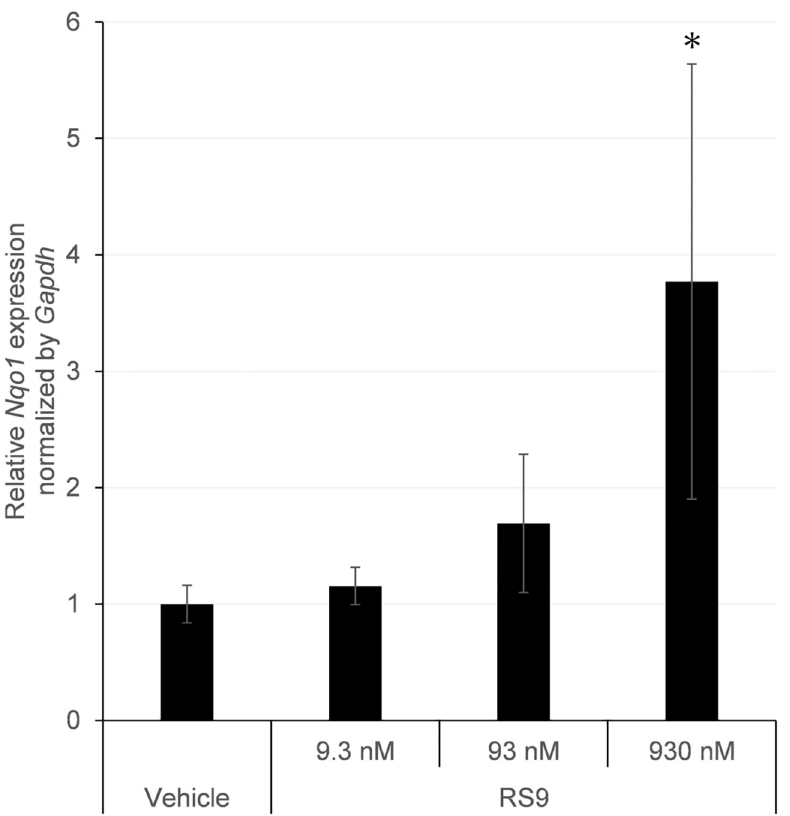
Fig 4. RT-qPCR analysis of Nqo1 mRNA in corneal epithelium from rats treated with topical administration of RS9. RS9 was topically administrated to rat eyes at concentrations of 9.3–930 nM. Fold changes were compared with expression levels in the vehicle group. The topical administration of 930 nM RS9 significantly induced Nqo1 mRNA expression. Data are presented as the mean ± SD (N = 6–7). � P < 0.01, compared with vehicle, Dunnett’s